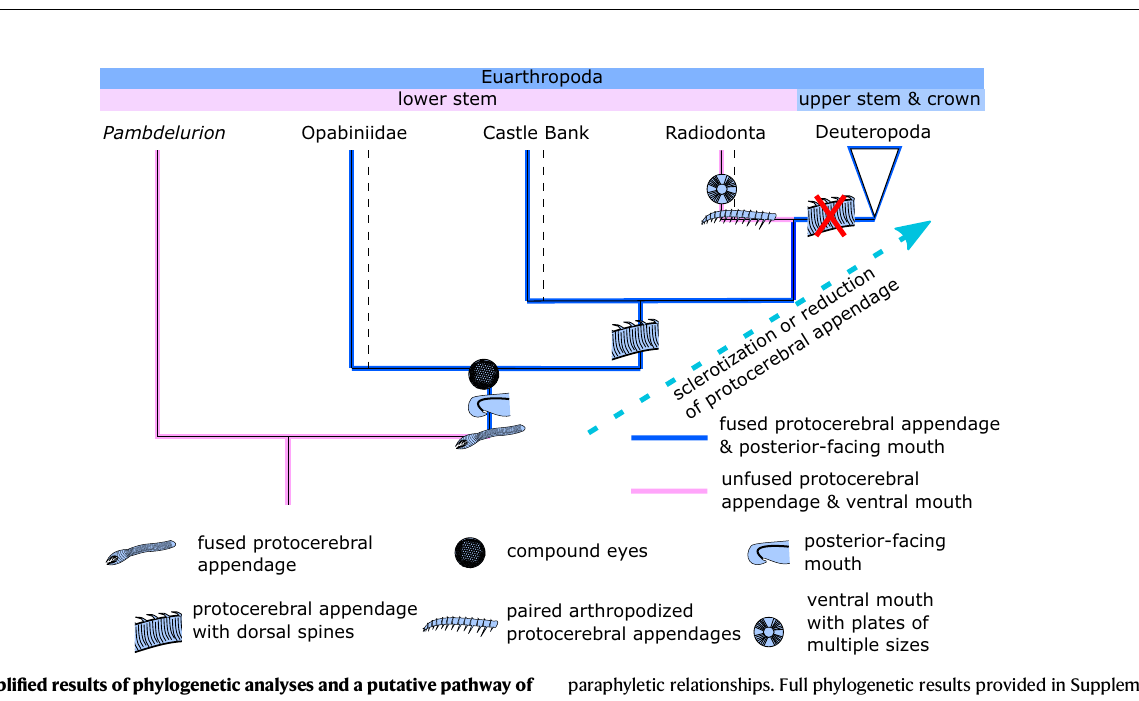
Fig.9|DetailsofposteriorbodyandtailfanofCastleBankeuarthropodA(NMW.2021.3G.8). cb-lleftcaudalblade,cb-rrightcaudalblade,dfdorsalfurrow, fl lateral fl ap, sp